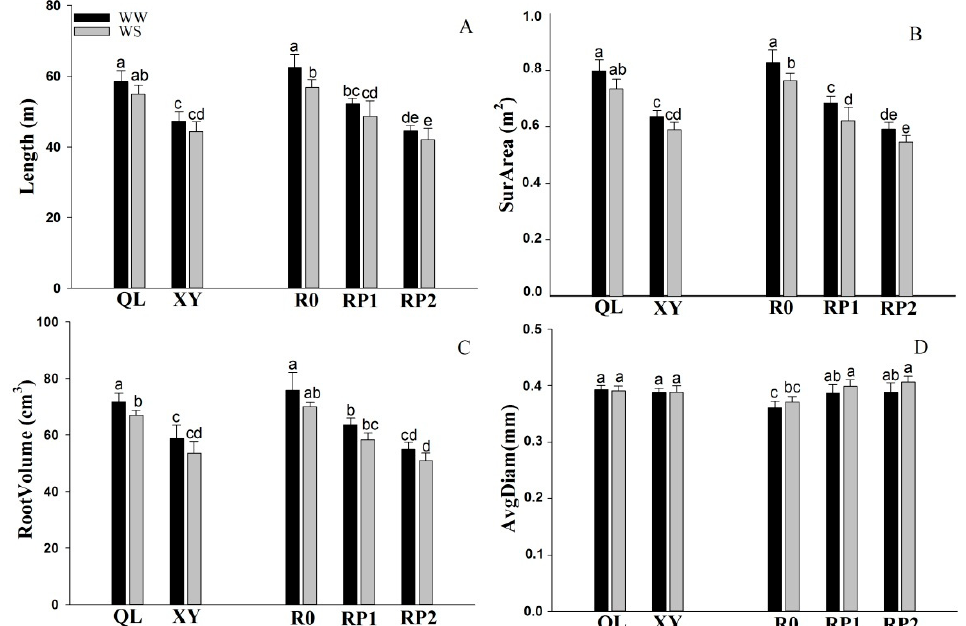
Figure 1. Total root length ( A ), root surface area ( B ), root volume ( C ), and average root diameter ( D ) under well-watered conditions (WW) and drought stress (WS) at jointing stage. QL (large root variety), XY (small root variety), R0 (no root pruning), RP1 (small root pruning) and RP2 (large root pruning). Values are means ± standard error ( n = 3). Different letters indicate statistically significant differences ( p < 0.05) after ANOVA and Duncan’s test.